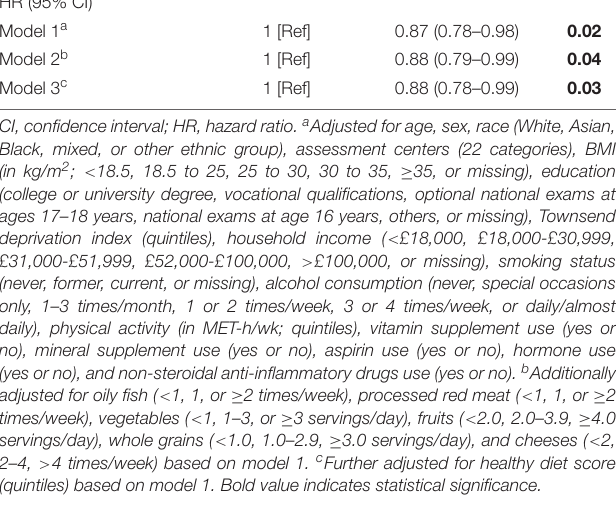
(quintiles) based on model 1. Bold value indicates statistical